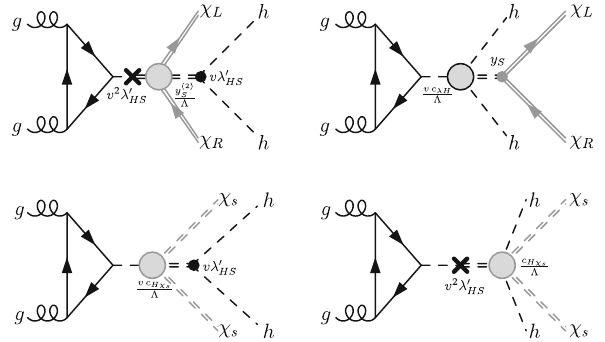
Fig. 9 Selected diagrams contributing to Higgs pair production in association with / E T , turning on the interactions ∼ λ (cid:3) c λ H , y S in the case of fermionic DM (first row) and ∼ λ (cid:3) case of scalar DM (second row). See text for details